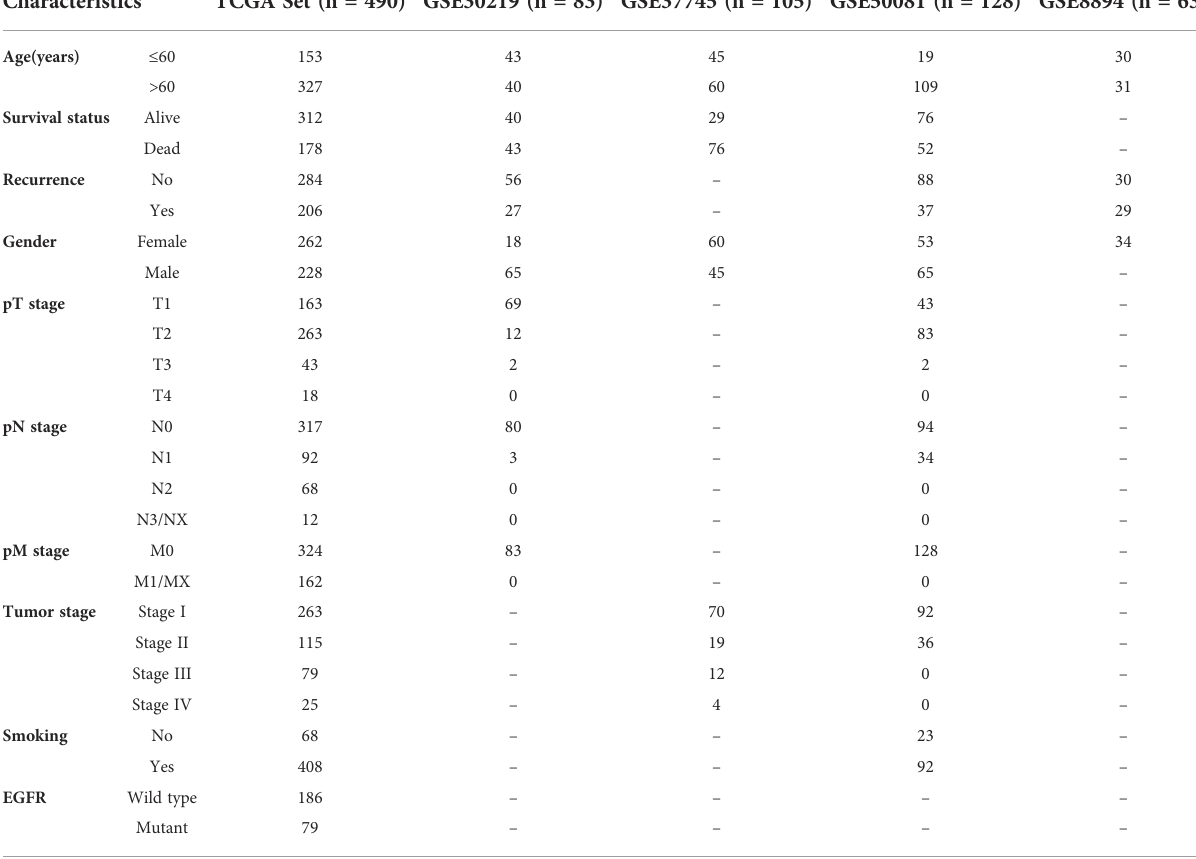
TABLE 1 Various clinicopathological characteristics of patients with LUAD in TCGA training cohort and GEO datasets.